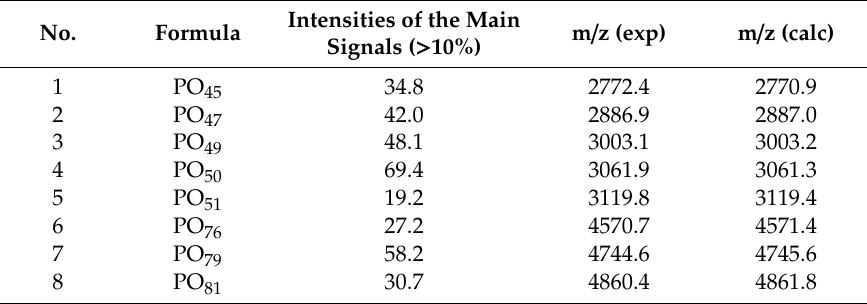
Table 10. PPO-diols accompanied by PO / PGE copolymerization initiated with K-DPG /